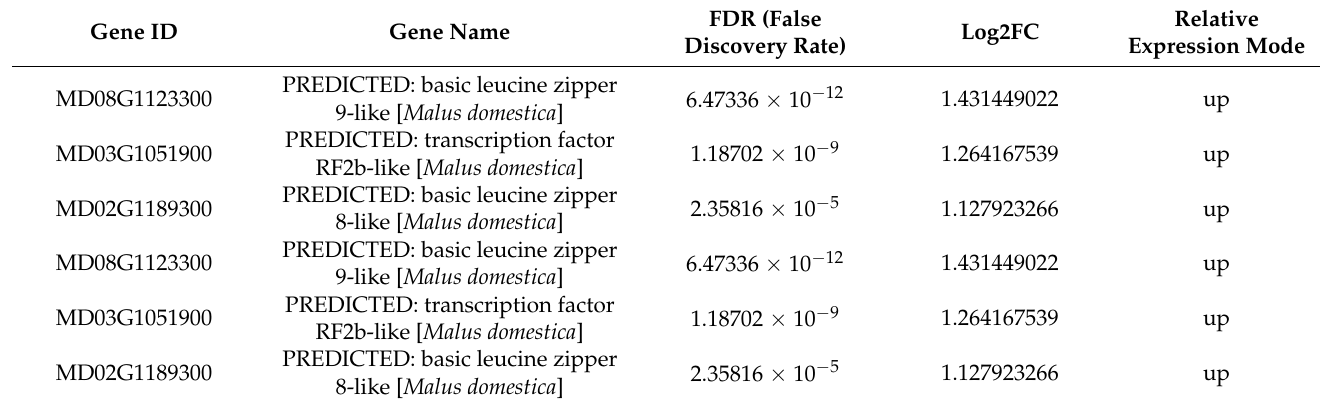
Table 3. Differentially expressed bHLH transcription factors in LF and GLF